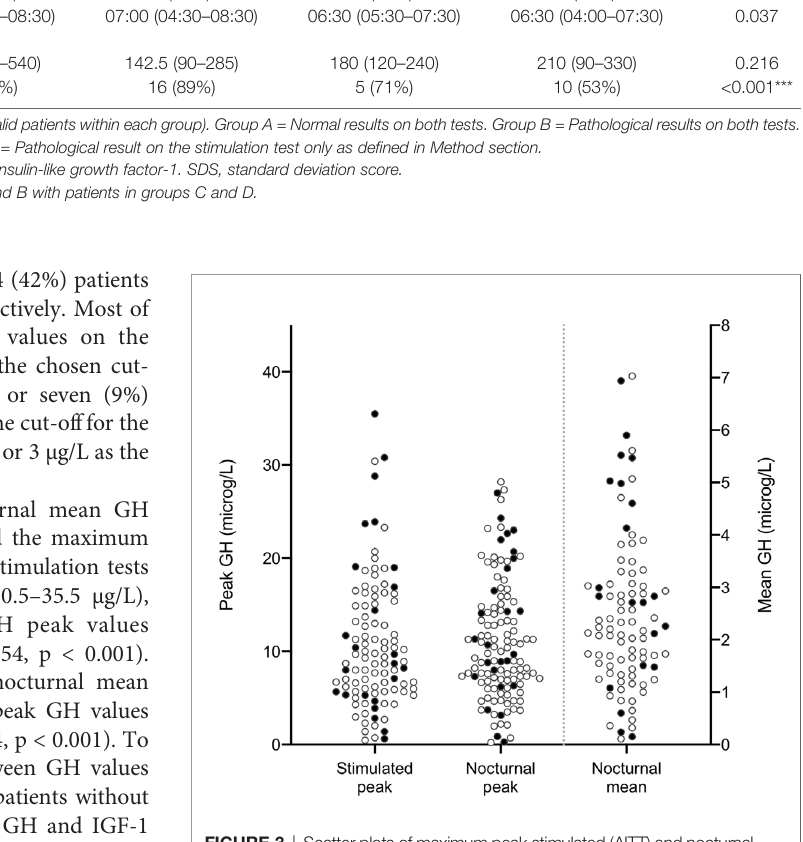
FIGURE 3 | Scatter plots of maximum peak stimulated (AITT) and nocturnal spontaneousGH values and nocturnal mean values (µg/L)in 123 children with short stature evaluatedfor possibleGHD.AITT, arginine-insulin tolerance test. GH, growth hormone. GHD,growth hormone de fi ciency. Open circles represent prepubertal patients and fi lled circles represent pubertal or primed